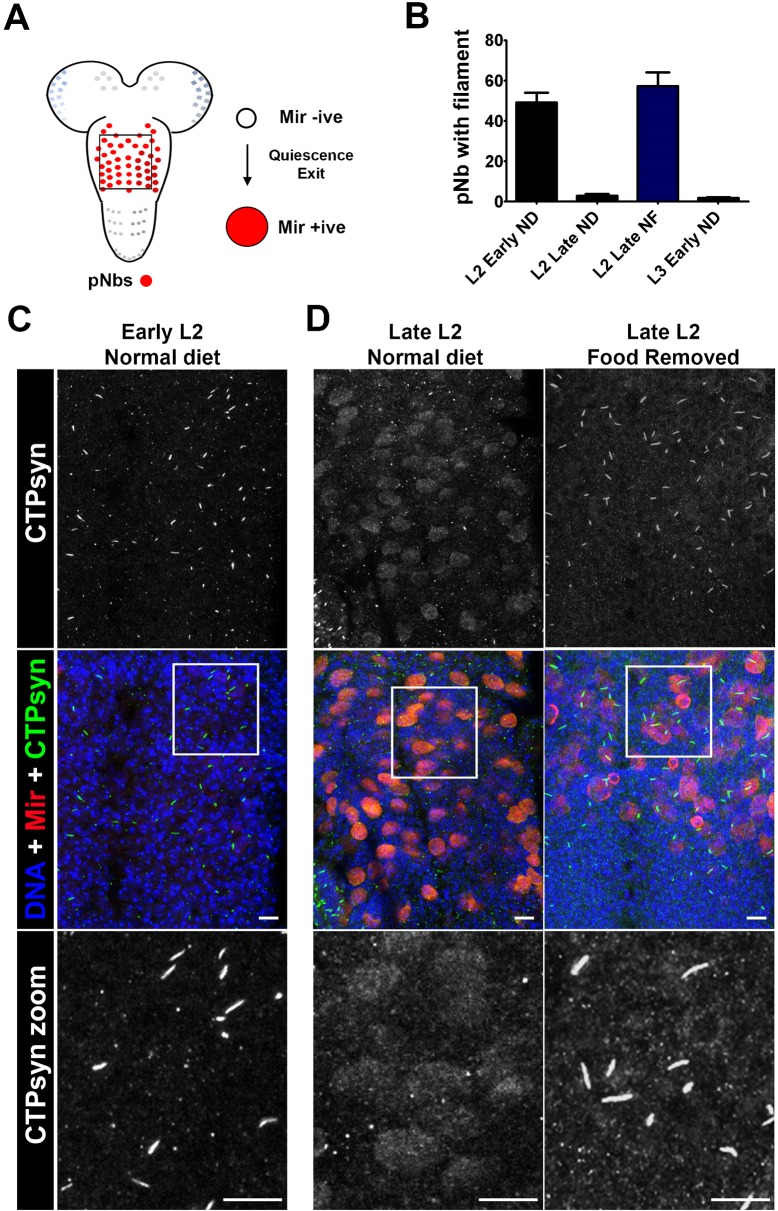
CTPsyn distribution in Drosophila larval post embryonic neuroblasts (pNbs).(A) A schematic of the larval CNS showing the location of the pNbs. The box represents the section of the CNS represented in panels C and D. The majority of larval pNbs exit quiescence during the late L1 (1st instar) and early L2 (2nd instar) stages. This is characterised by pNb enlargement and the expression of markers such as Miranda (Mir). (B) Counts of pNbs containing cytoophidia in L2 early, L2 late and L3 larvae early reared under different feeding conditions (ND, normal diet; FR, food removed). n>10 animals per group. (C) CTPsyn localisation in early and late L2 when on a normal diet (see Materials and Methods). CTPsyn forms cytoophidia in quiescent pNbs (Mir negative). (D) As neuroblasts exit quiescence (late L2, normal diet) and begin to divide CTPsyn becomes diffuse. (E) CTPsyn localisation in late L2 when food is removed (late L2, food removed) after 24 hrs. CTPsyn aggregates into filaments when nutritional stresses are present. These images are representative of all 10 animals imaged. Scale bars: 10 µm.